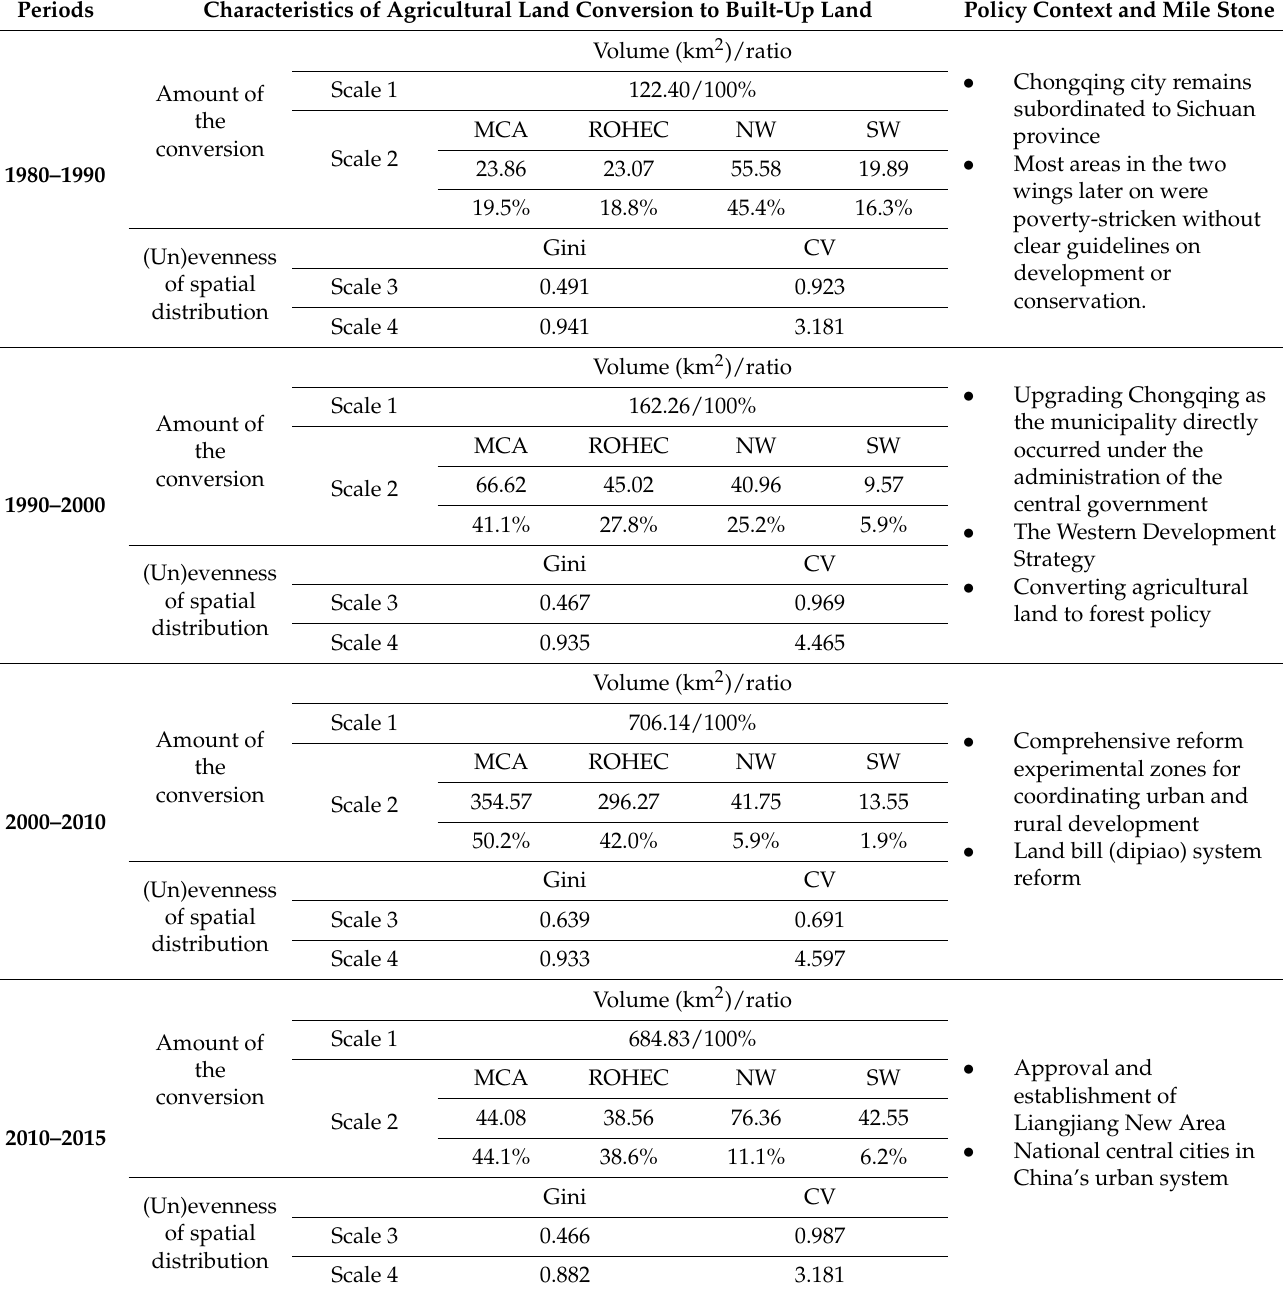
Table 3. A multiscale understanding of agricultural land conversion to construction land in Chongqing 2 .